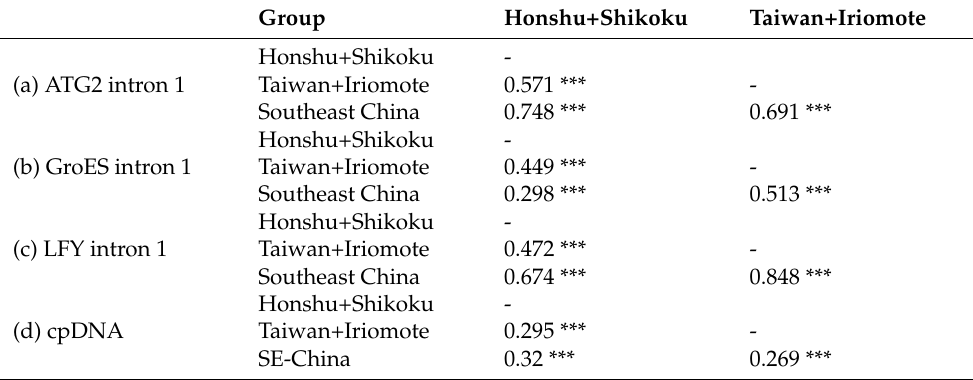
Table 3. Pairwise Fst estimates from four loci of three identified C. ramondioides groups.